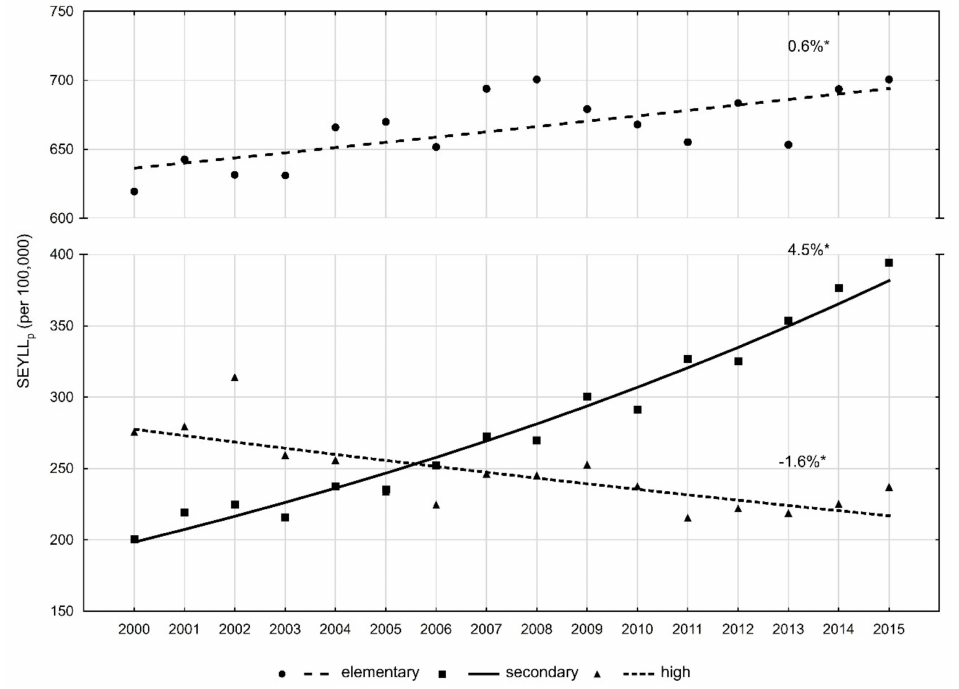
Figure 2. Time trends of the standard expected years of life lost per living person (SEYLL p ) index due to prostate cancer by education in 2000–2015 in